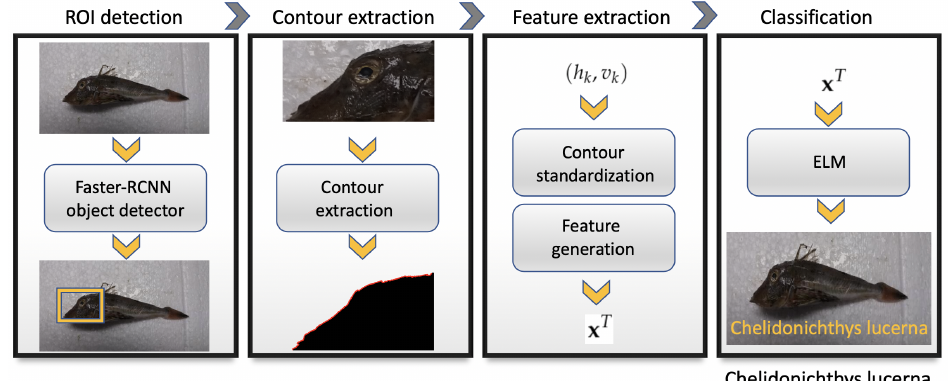
Figure 13. Simplified block diagram of the process chain when the ROI detection is done automatically.